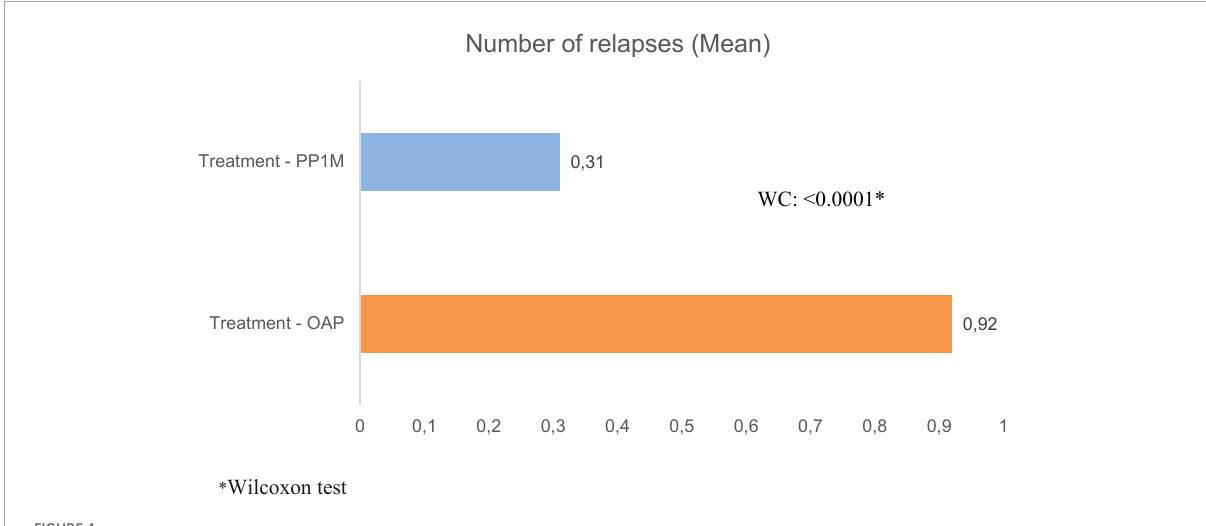
FIGURE4 Comparison between samples for the mean number of relapses over the observation period—12 months on treatment. *Wilcoxon